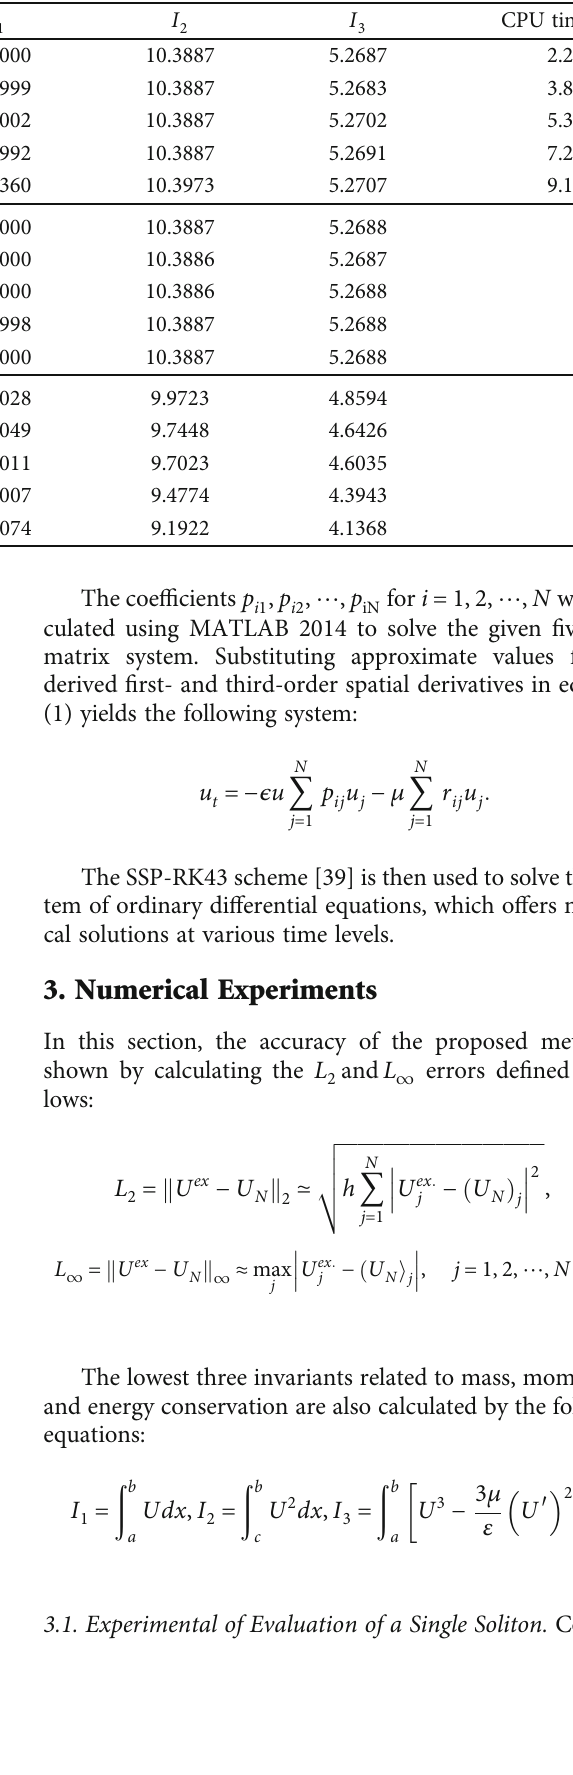
Table 6: Experimental evaluation of the interaction of four solitons: Δ t = 0 : 1